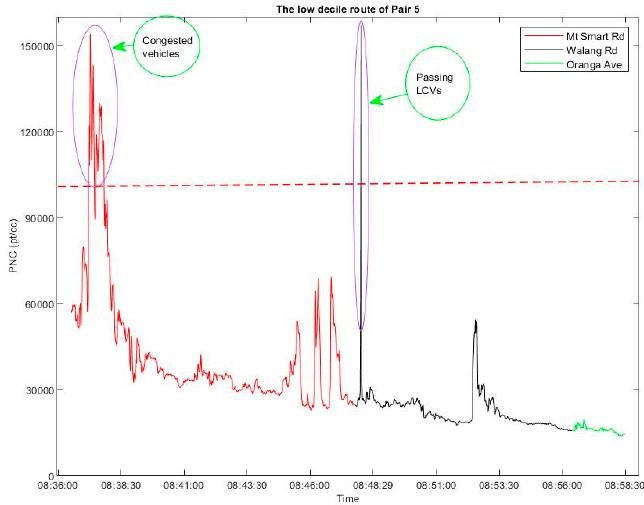
Figure 11. Sources of PNC spikes on the low decile route of Pair 5 (using the data collected on 5 July). The red line represents the measured PNC in the main segment of the route. The black and green lines are the data collected through quiet streets.